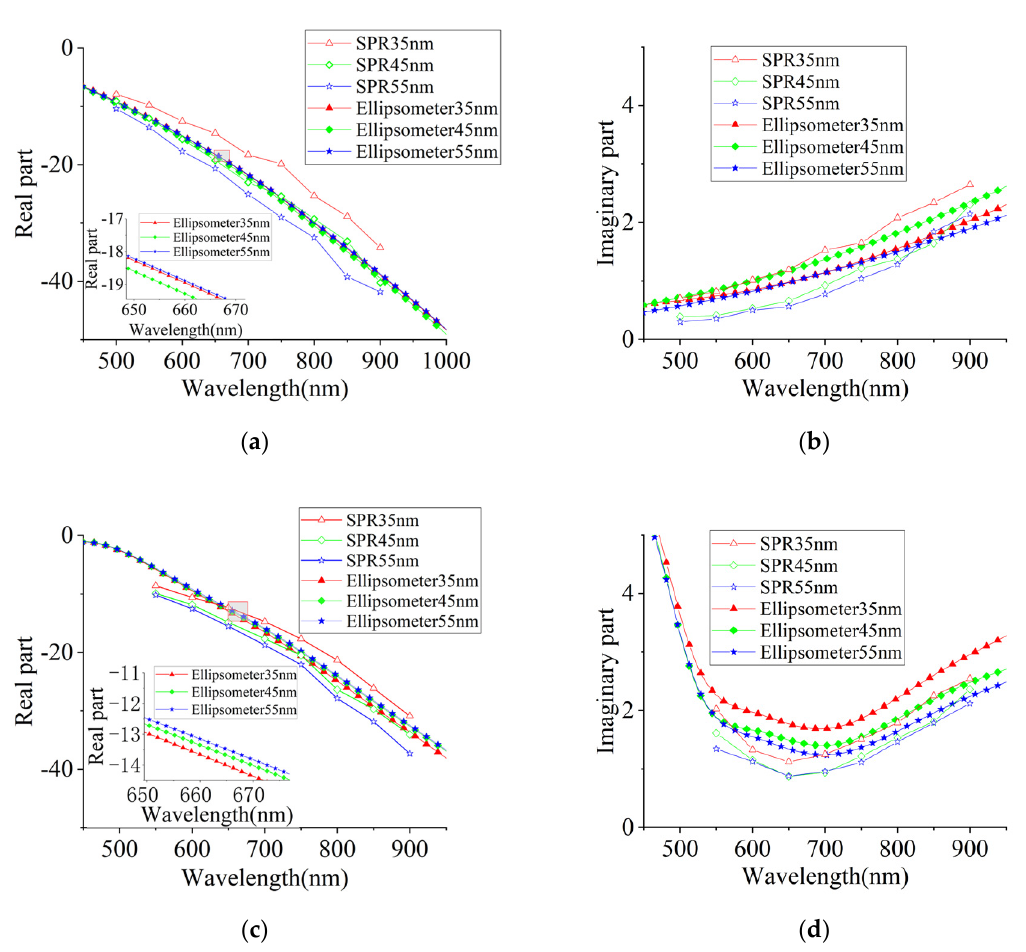
Figure 8. The dielectric constant measurement results of the SPR and Ellipsometer: ( a ) the real part of the silver films; ( b ) the imaginary part of the silver films; ( c ) the real part of the gold films; and ( d ) the imaginary part of the gold films.